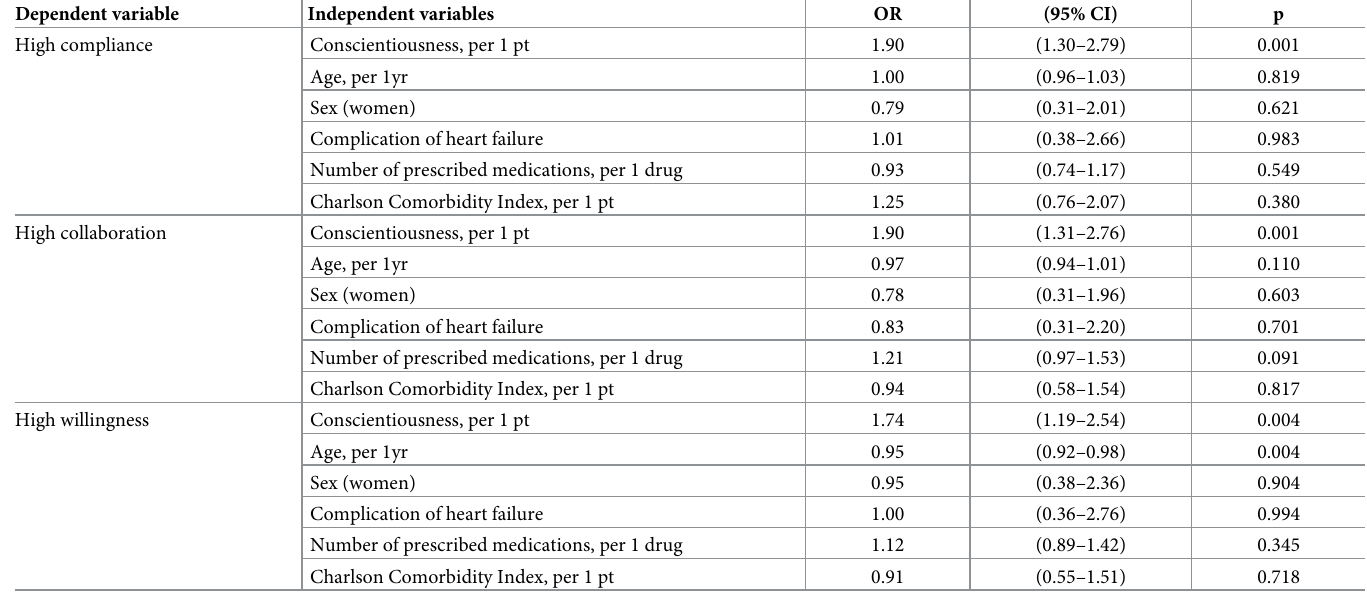
Table 3. Results of multivariate logistic regression